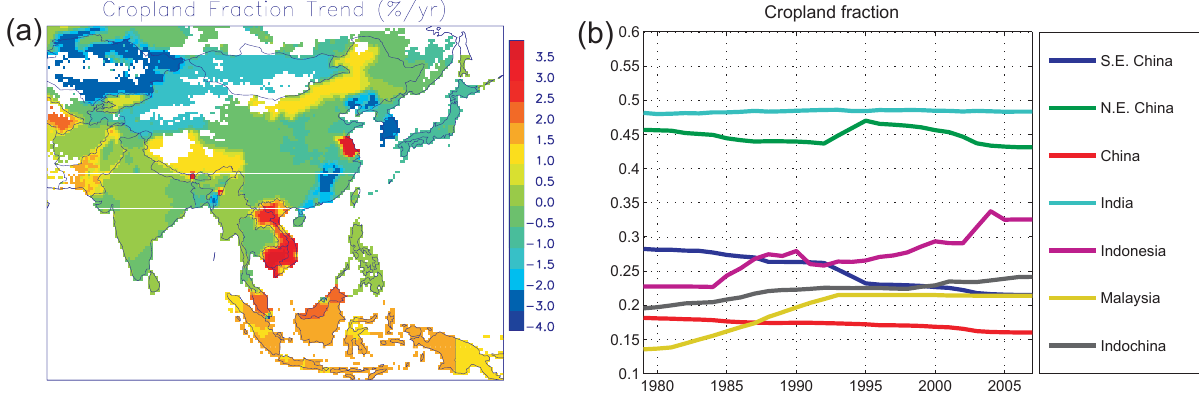
Fig. 1. (a) Trend distribution of cropland fraction between 1979 and 2007. (b) Evolution of cropland fraction per country between 1979 and 2007. Source: Ramankutty and Foley (1999) and updates (http://www.geog.mcgill.ca/~nramankutty/Datasets/Datasets.html).